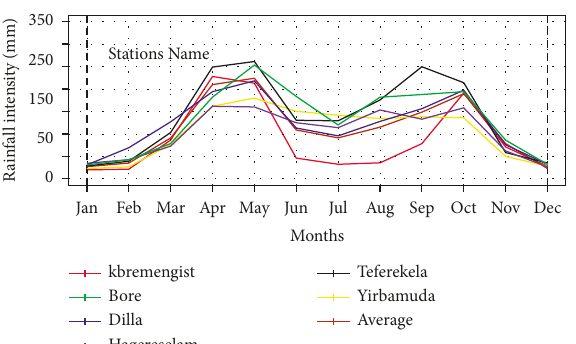
Figure 2: Monthly rainfall pattern at each station in the Awata